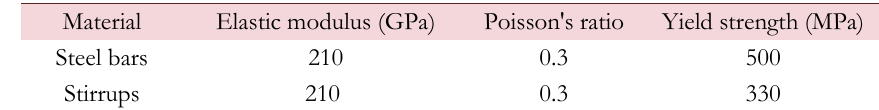
Table 6: The mechanical properties of steel reinforcement from experimental work .